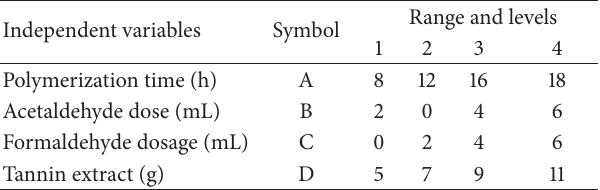
Table 1: Designs and levels of Taguchi